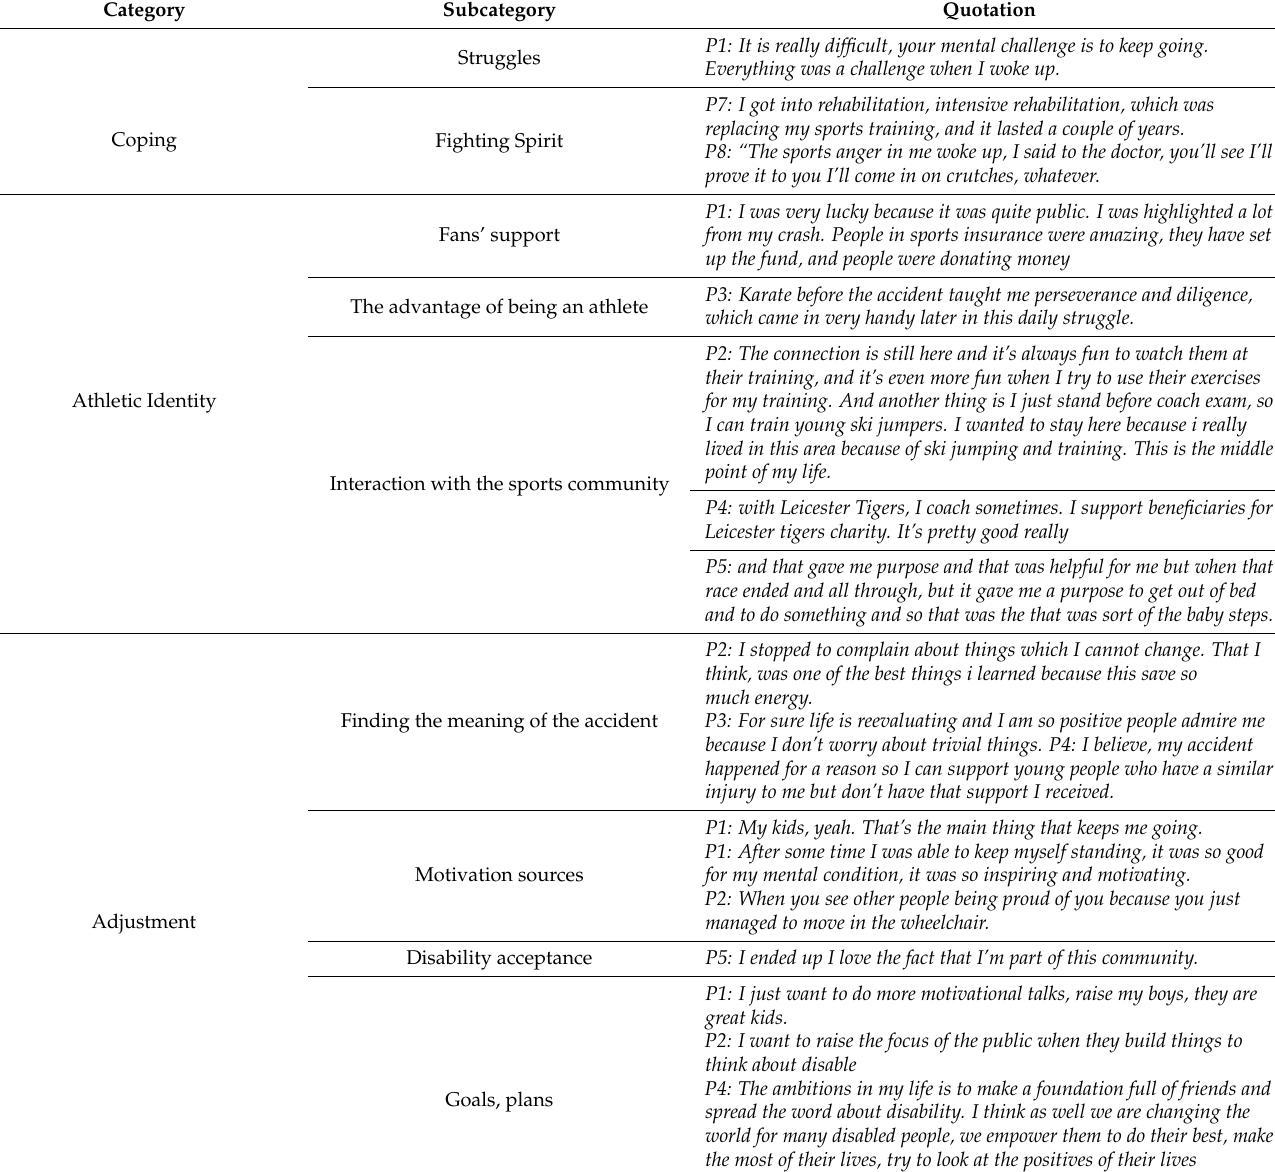
Table 2. Topics by